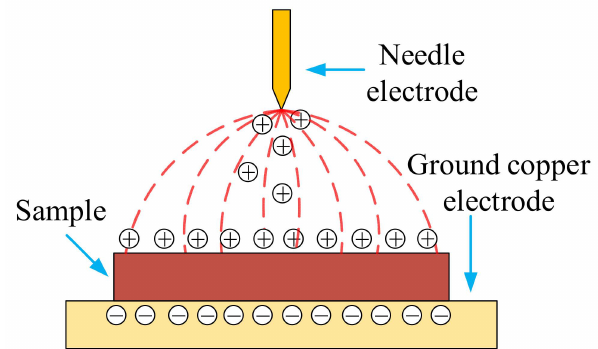
Figure 17. Charge distribution characteristics of insulating dielectric surface without airflow.